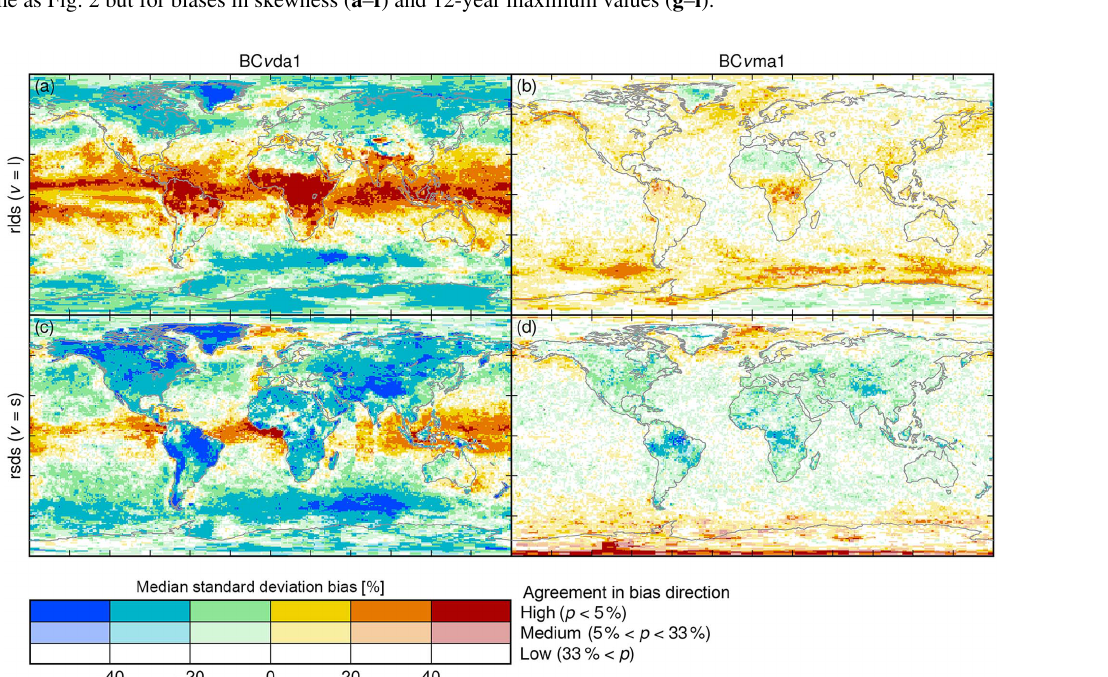
Figure 4. Same as Fig. 2 but for relative biases in interannual standard deviations of monthly mean radiation remaining after bias correction with methods BC v da1 (left) and BC v ma1